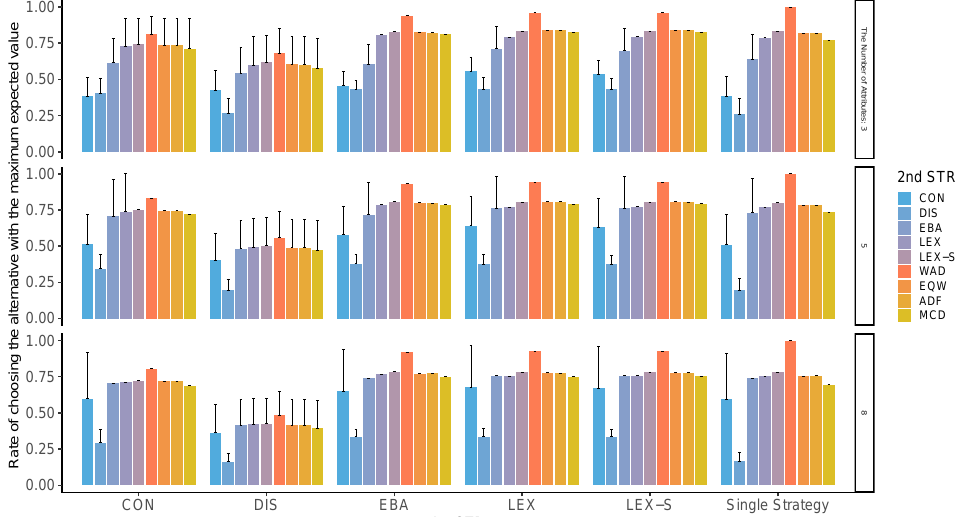
Figure A16. Best-choice rate in two-stage decision-making when three alternatives are left in the second stage for the different numbers of attributes. ADF: additive difference; CON: conjunctive; DIS: disjunctive; EBA: elimination by aspects; EQW: equal-weighted strategy; LEX: lexicographic; LEX-S: lexicographic semi-order; MCD: majority of confirming dimensions; STR: strategy; WAD: weighted